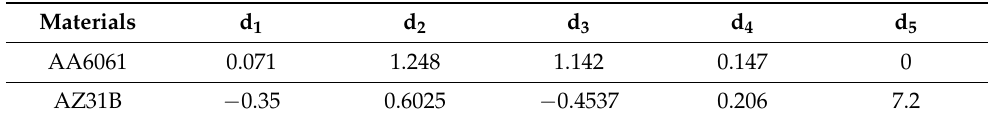
Table 5. The Johnson–Cook damage parameters for AA6061 and AZ31B [28,29]. Materials d